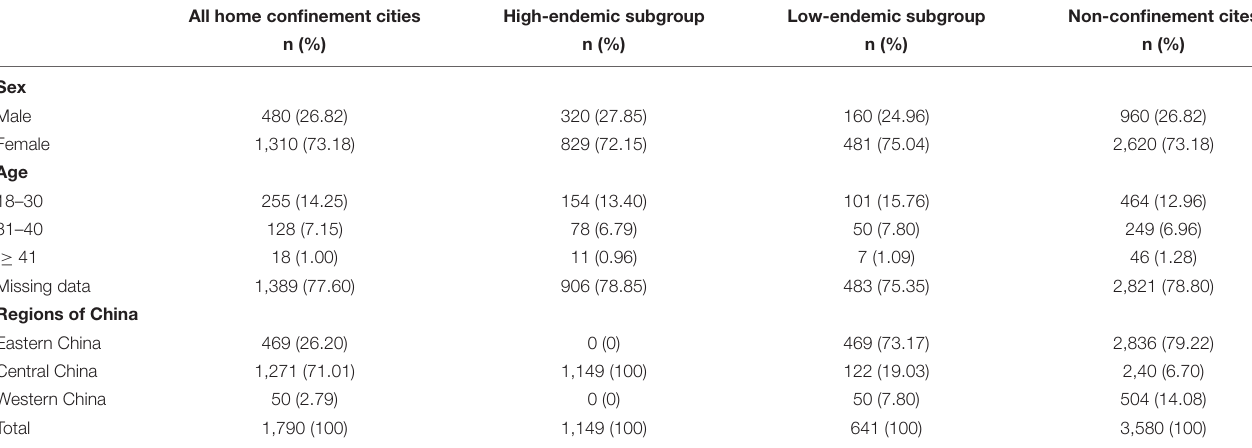
TABLE 2 | Demographic characteristics of the selected participants.